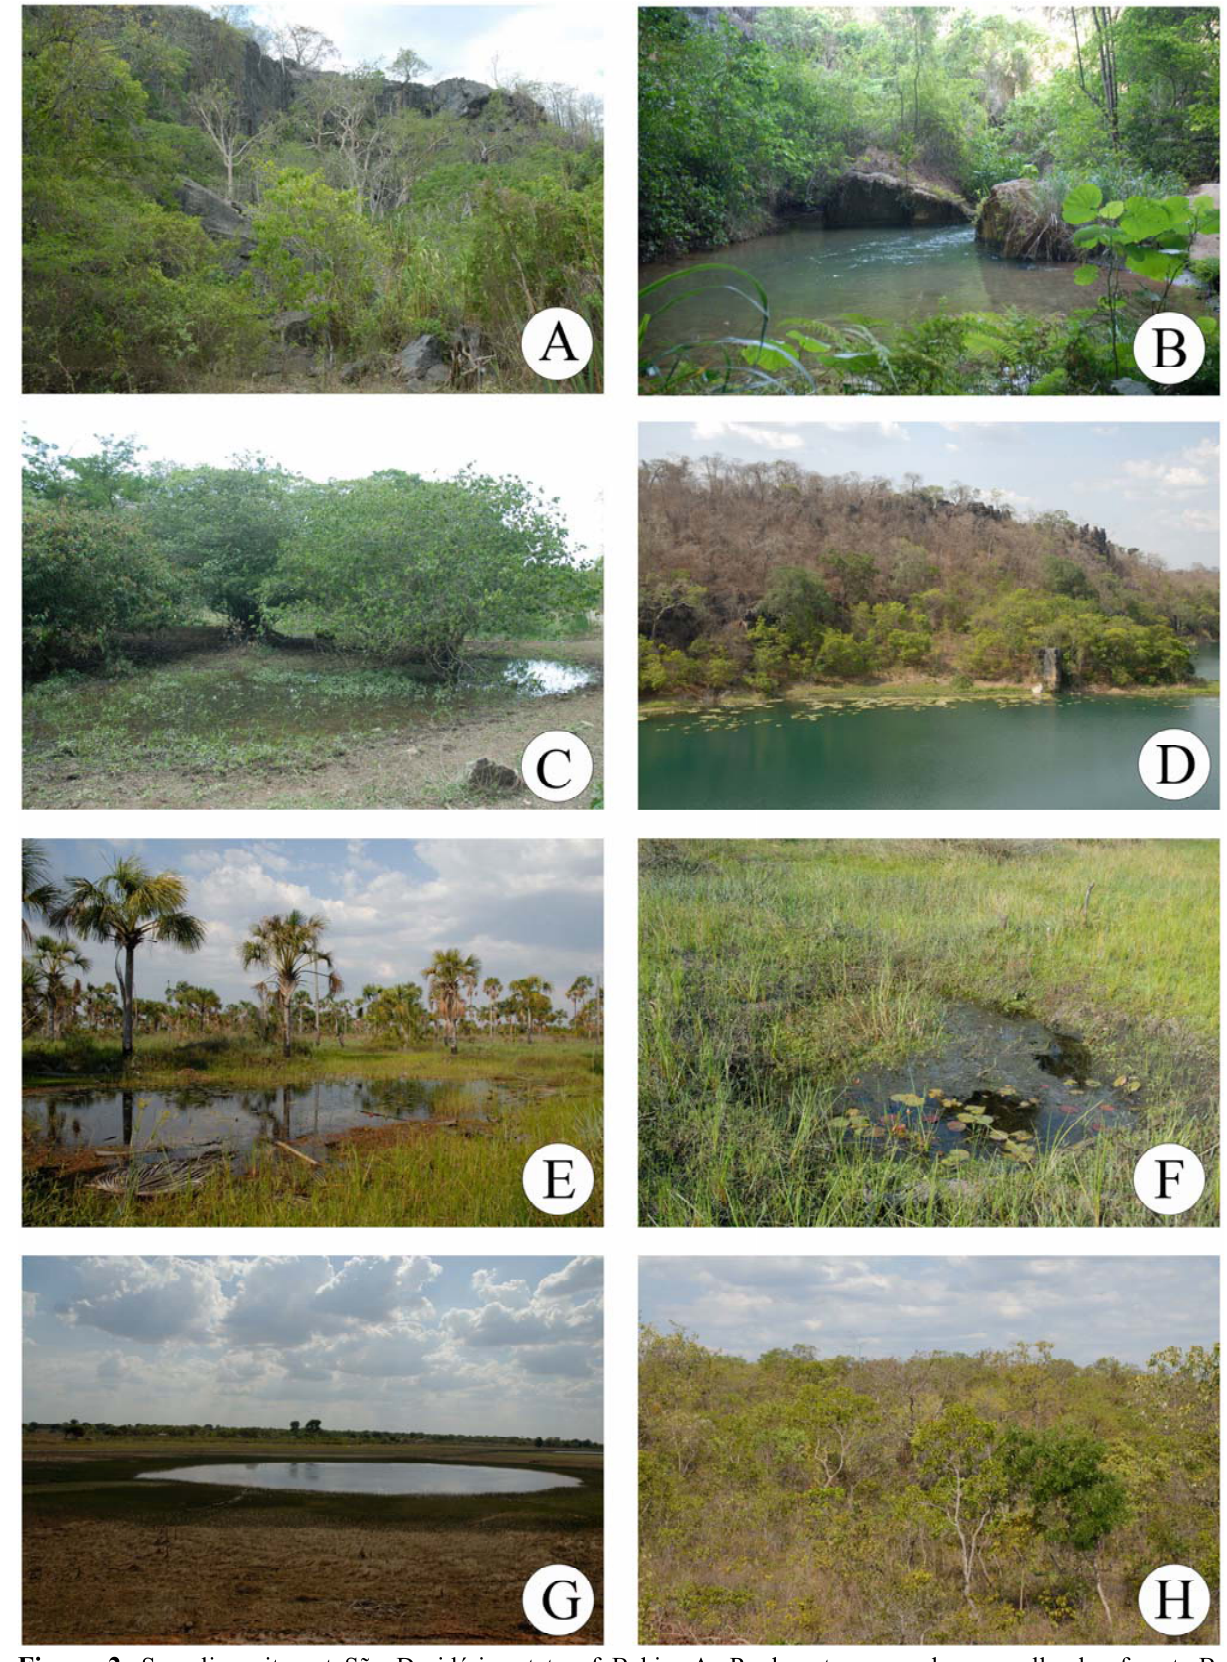
Figure 2. Sampling sites at São Desidério, state of Bahia. A. Rock outcrops and seasonally dry forest; B. Permanent pond at Parque Municipal Lagoa Azul ; C. Temporary pond at São Desidério river flooded margins; D. Sinkhole and temporary dry forest at Parque Municipal Lagoa Azul ; E. Vereda do Anastácio ; F. Vereda do Anastácio ; G. Permanent pond at Campo Grande; H. Typical cerrado crossed by the road to Correntina. Photo: P. H.